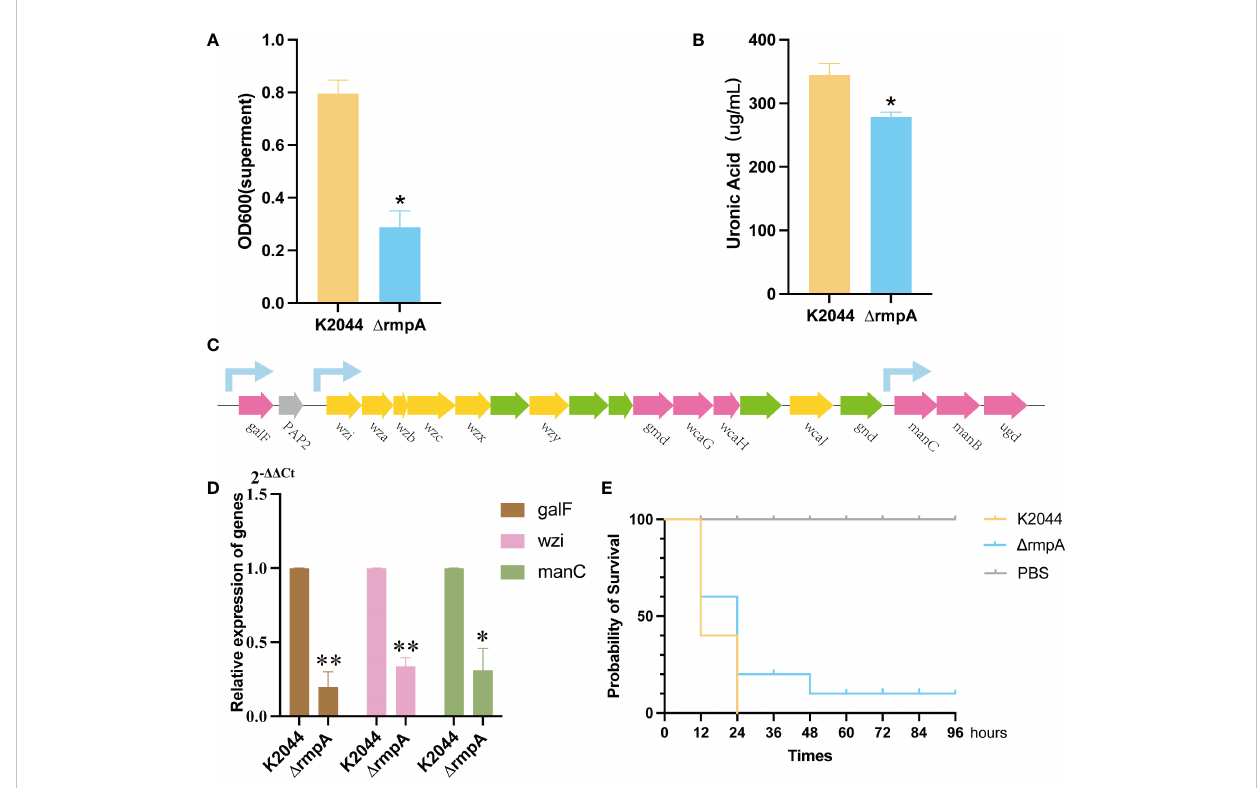
FIGURE 8 The effect of rmpA on the capsule and virulence of Klebsiella pneumoniae . (A) Capsule mucoviscosity. (B) Uronic acid production. (C) A diagram showing the location of cps clusters with the sequences of K2044 strains and the location of the relevant promoters. (D) qRT-PCR results for expression of galF , manC , and wzi in the K2044 and D rmpA strains (2 - DD Ct ). (E) The Galleria mellonella infection model. A log-rank (Mantel – Cox) test was used to analyze the survival curves. Data were analyzed via one-way ANOVA. **P < 0.01, *P <